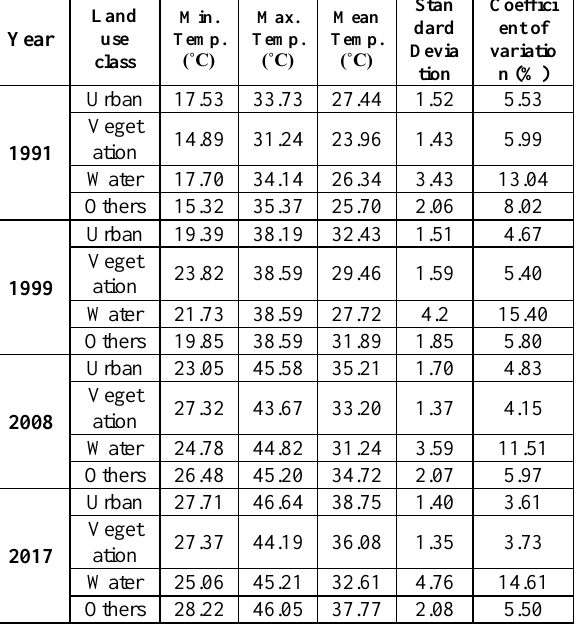
Table 8: Temperature statistics for Chandigarh with 10 km